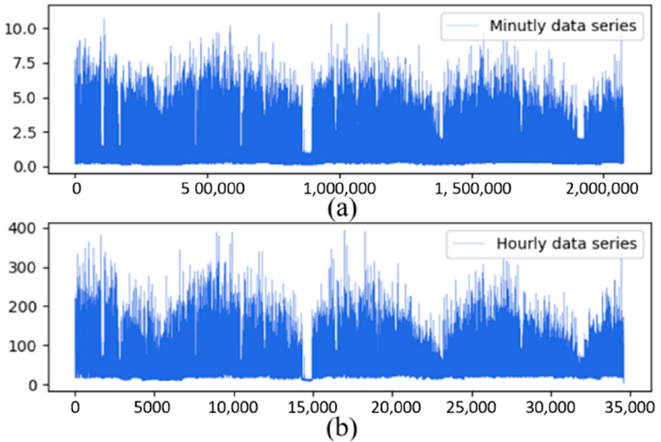
Figure 2. Data down sampling where “( a )” shows actual minute data and “( b )” shows hourly down-sampled data.